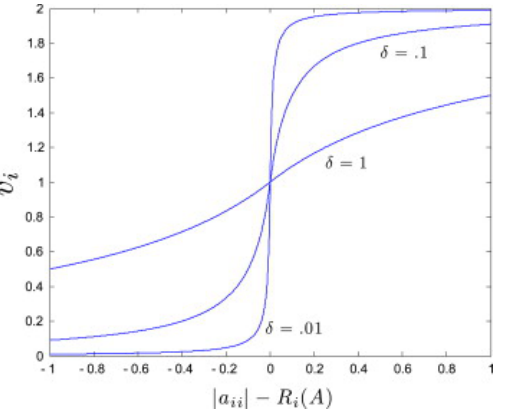
Figure 1. Plot of v i as a function of the entries | a ii | − R i ( A ) , for average β = 0 and different values of the parameter 0 < δ ≤ 1. Taken from